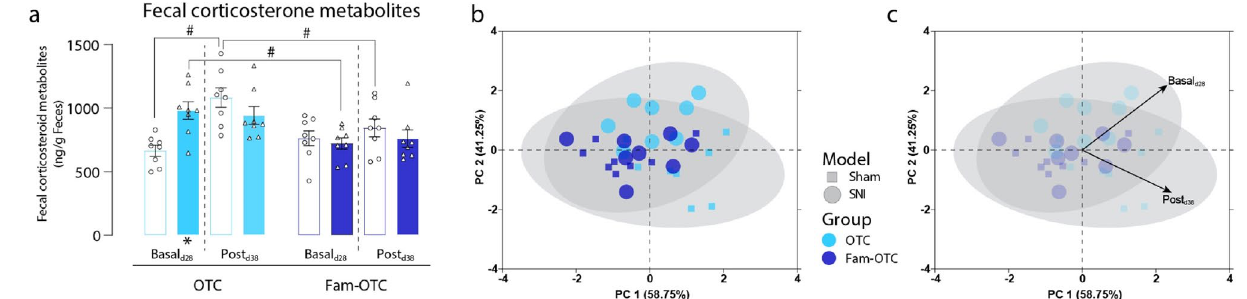
Figure 3. Experimenter familiarization decreases fecal corticosterone metabolites. ( a ) In spared nerve injury (SNI) mice of the open top cage (OTC) group, a significant increase in fecal corticosterone metabolites (FCMs) was observed at d28 (basal) but not d38 (post) after the behavioral test. However, FCMs increased significantly between d28 and d38 in sham mice in the OTC group. In the group comparison of housing conditions, a significant decrease in FCM levels was detected in the experimenter familiarized (Fam-OTC) group. ( b, c ) Principle component (PC) analyses revealed significant group segregation between OTC and Fam-OTC housing conditions, in both sham and SNI mice, with the OTC characterized by higher basal and post FCM values. Within the OTC group, significant segregation between sham and SNI was observed. Results are expressed as mean ± SEM. N = 8 for all groups. Two-way ANOVA (repeated measures based on GLM) followed by Dunnett’s multiple comparison test. *For comparison to sham; p values: * ≤ 0.05, ** ≤ 0.01, *** ≤ 0.001. #For comparison to